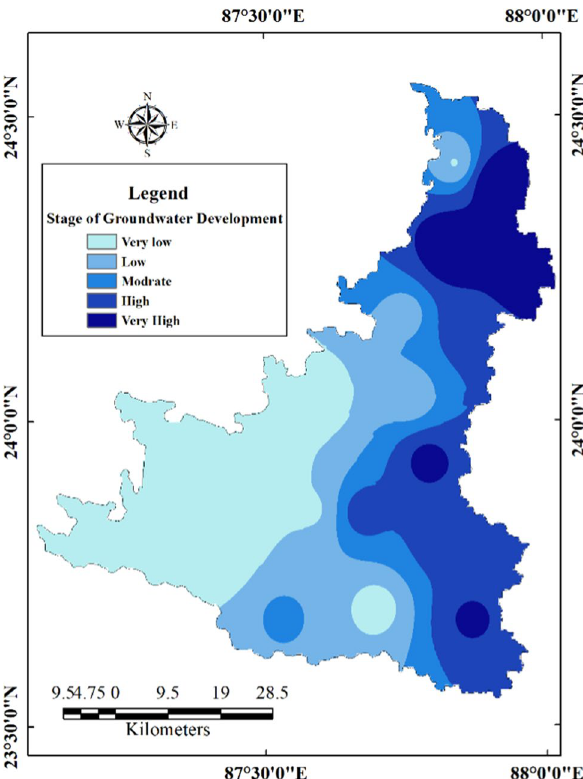
Fig. 23 Stage of groundwater development